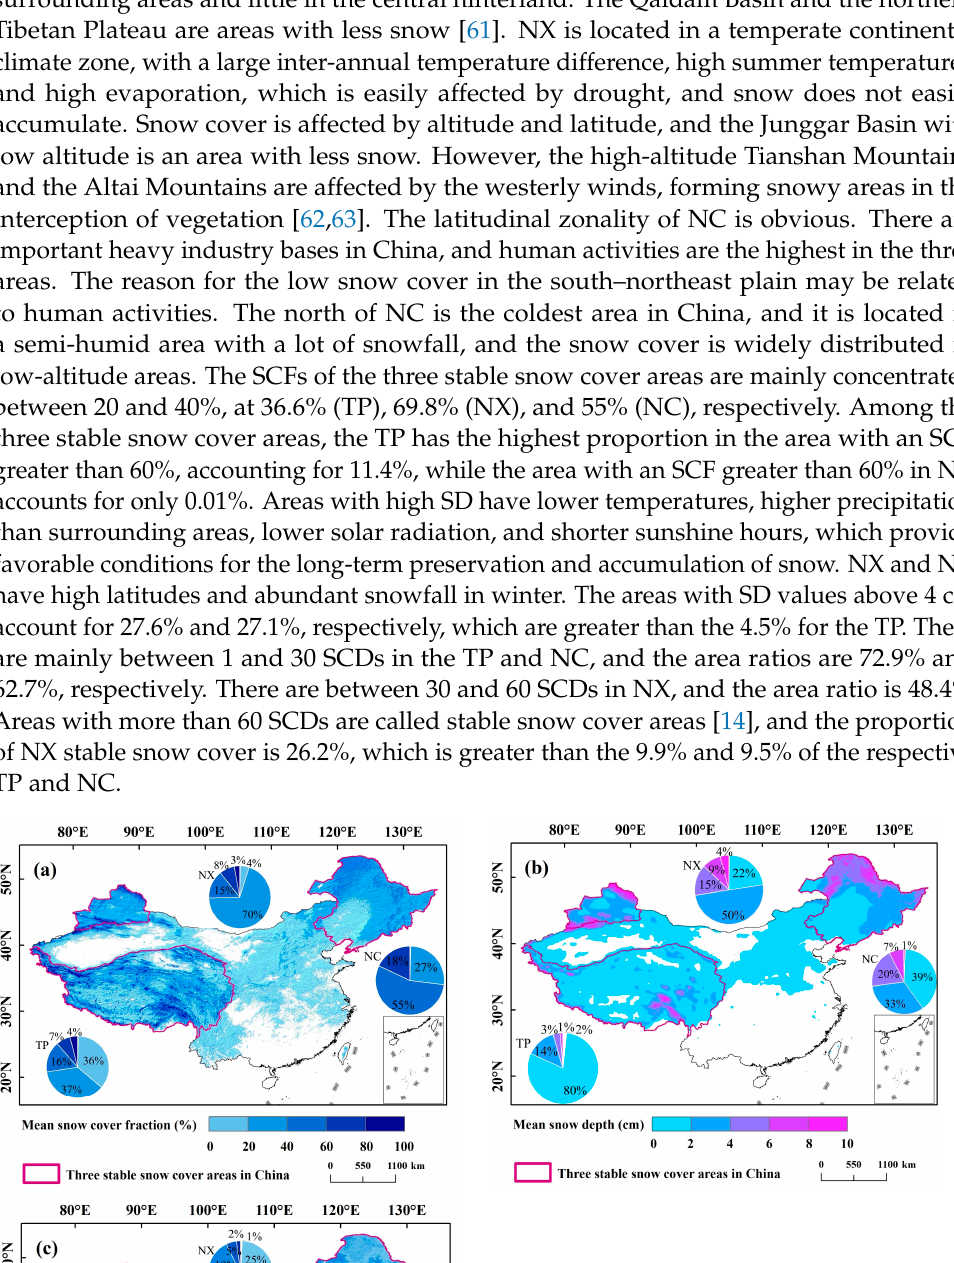
Figure 6. Spatial distribution of variation ratios and the significance of SCF ( a ), SD ( b ), and SCDs ( c ) in the TP, NX, and NC from 2001 to 2019 or 2020. The TP snow cover increased in the area between the Bayankala Mountains and Qi- lian Mountains in the northeast and the Himalayas in the southwest, and decreased in the Nianqing Tanggula Mountains and Hengduan Mountains in the southeast and the North- ern Tibetan Plateau in the middle. The change in NX snow showed a change trend from southwest to northeast. The snow in the eastern Tianshan and Altai Mountains showed an increasing trend, and the central Junggar Basin mainly showed a decreasing trend. NC showed an increasing trend in the area between the Daxinganling and the Xiaoxinganling in the central part, and a decreasing trend in the southern Liaodong Peninsula and the northern part of the Daxinganling (SCF, SD) in the north. Among the three stable snow cover areas, the area with no change in the SCF accounted for the largest proportion, and the area where the SCF of the TP and NC showed an increasing trend was larger than the area that showed a decreasing trend. Areas with significant changes in the SCF showed